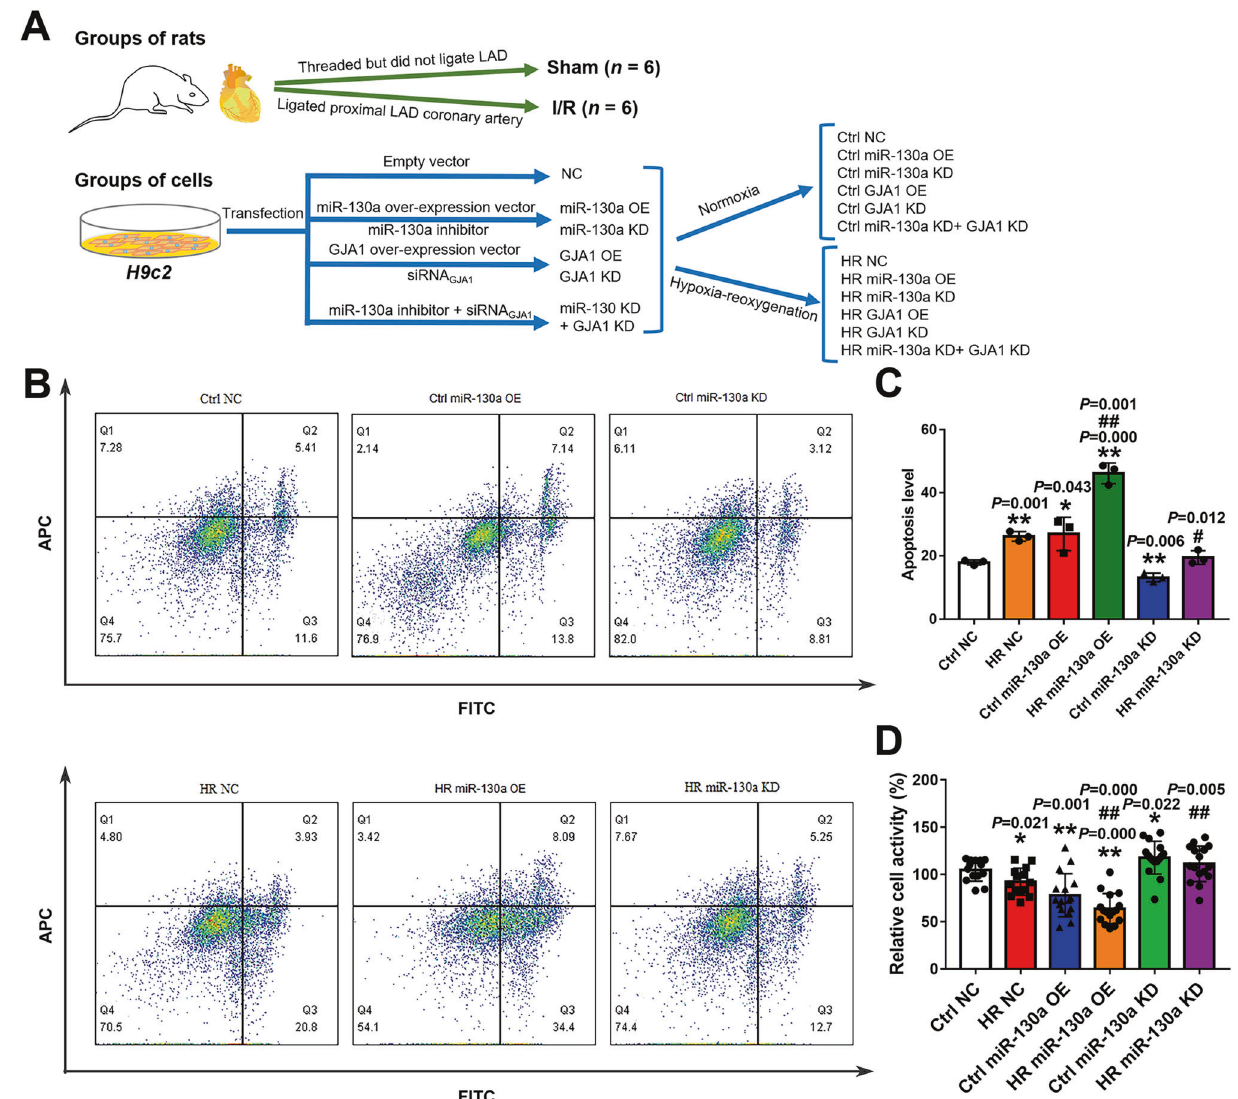
Fig. 2 The experimental grouping of animals and cells and the effect of miR-130a on activity and apoptosis of myocardial cells. A We grouped the SD rats (male, 10 weeks, n = 12) and H9c2 cells, and showed the treating processes. The proximal left anterior descending (LAD) coronary artery of rats ( n = 6) was ligated to induce myocardial ischemia for 45 min followed by reperfusion for 6 h in the I/R group, and the heart samples were obtained for experiments. The sham group ’ s SD rats ( n = 6) underwent the same procedures but did not ligate LAD after threading. In groups of cells, to edit the gene expression, H9c2 cells were transfected with vectors, siRNA, or inhibitors. Next, to Simulate IRI in vitro, H9c2 cells were grown in Hanks ’ balanced salt solution under 95% N 2 and 5% CO 2 for 45 min, then under 20% O 2 and 5% CO 2 while the medium was changed to DMEM re-oxygenating for 6 h in the Hypoxia-reoxygenation (HR) groups. H9c2 cells of the normoxia group were grown in DMEM under 20% O 2 and 5% CO 2 . Heart tissue of rats and H9c2 cells of each group were collected for subsequent experiments. NC: negative control; OE: over-expression; KD: knockdown. Normoxia: cells grow under 20% O 2 and 5% CO 2 . Hypoxia-reoxygenation: cells grow in Hanks ’ balanced salt solution under 95% N 2 and 5% CO 2 for 45 min, then under 20% O 2 and 5% CO 2 in DMEM for 6 h. B , C Apoptosis in H9c2 cells was measured by Flow Cytometry under normoxia or HR conditions with miR-130a OE or miR-130a KD. n = 3 in each group. D Cell viability was determined by using a cell counting kit-8 under normoxia or HR conditions with miR-130a OE or miR-130a KD and absorbance was measured at 450 nm. n = 14 in the Ctrl NC and HR NC group; n = 16 in the Ctrl miR-130a OE, HR miR-130a OE, Ctrl miR-130a KD, and HR miR-130a KD group. Relative cell activity (%) = [(As-Ab)/(Ac-Ab)] ×100%. As: absorbance of the experimental group; Ab: absorbance of the blank group; Ac: absorbance of the Ctrl NC group. Data were expressed as mean ± SD by two-tailed Student ’ s t-test, * P < 0.05, ** P < 0.01 vs. Ctrl NC; # P < 0.05, ## P < 0.01 vs . HR NC. APC allophycocyanin, FITC Fluorescein us wonder whether the level of GJA1 expression changed accordingly. We measured GJA1 expression in myocardial I/R rats by WB (Fig. 5C), immunohistochemistry (IHC) (Fig. 5D), and immuno fl uorescence assay (IFA) (Fig. 5E), and show consistent results that GJA1 in the I/R group signi fi cantly decreased. Therefore, we reasoned that miR-130a aggravated mitochondrial dysfunction in myocardial IRI by regulating GJA1.